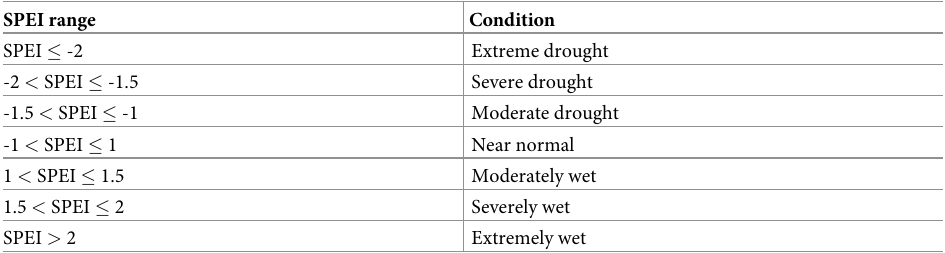
Table 1. SPEI range and